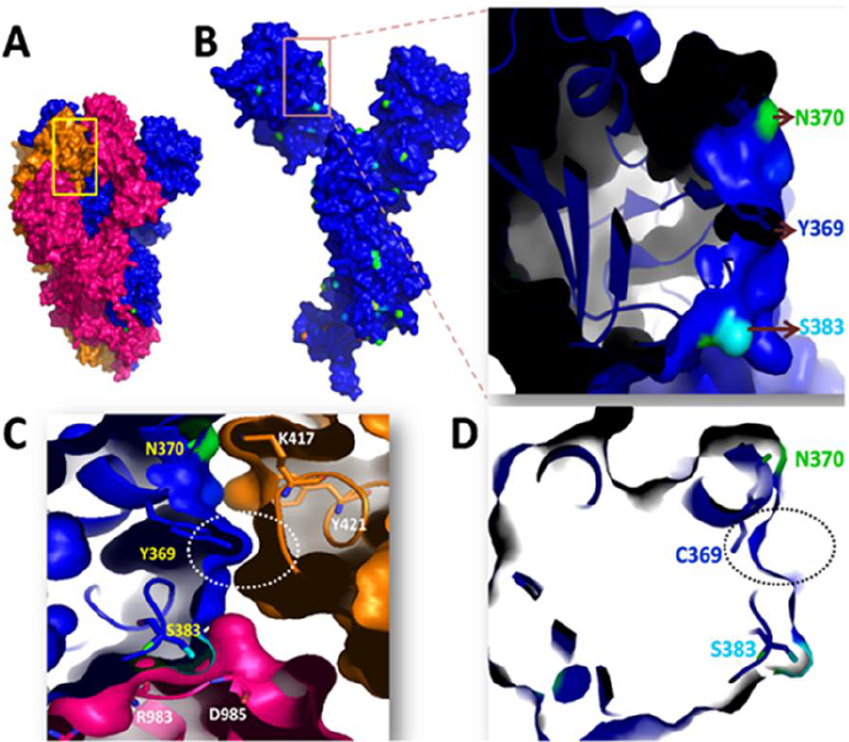
Figure 11. ( A ) The spike glycoprotein state is illustrated in the trimeric state, with protomers depicted in magenta, blue, and orange; ( B ) The surface area accessibility of spike protein is represented in one of the protomer states (blue). The inset represents the magnified view of Y369 residue along with nearby exposed amino acids (N370 and S383). The N370 is described in green, and S383 in cyan; ( C ) The involvement of Y369 residue in cavity filling is illustrated for different protomers (shown in a white circle) for structural integrity. The Y369, N370, and S383 of one protomer (blue) are shown in yellow; K417, Y421, R983, and D985 of nearby protomers (orange and magenta) are shown in white; ( D ) The mutated C369 lacks the binding cavity as shown in the black circle. Furthermore, Y369 interacts with EY6A, an antibody isolated from COVID-19 pa- tients, highlighting this mutation as a matter of concern since it could lead to antibody- escape mutants. The crystal structure reveals that EY6A Fab binds with the RBD of the spike reported in the PDB structure (PDB: 6ZDG). This interaction is seen between S383, T385, and K386 of the RBD and D33, D99, L103, W104, V105, and Y106 of the heavy chain of Fab. Y369 plays an essential role in maintaining RBD mAb interaction effectively intact; the Y369 of RBD is considered one of the important amino acids, binding with P384 (3.2 Å) to stabilize the loop-prone S383, T385, and K386 of the RBD domain (Figure 12A). After mutation to C369, its interaction with P384 (6.0 Å) loosens (Figure 12B). The rigidity of